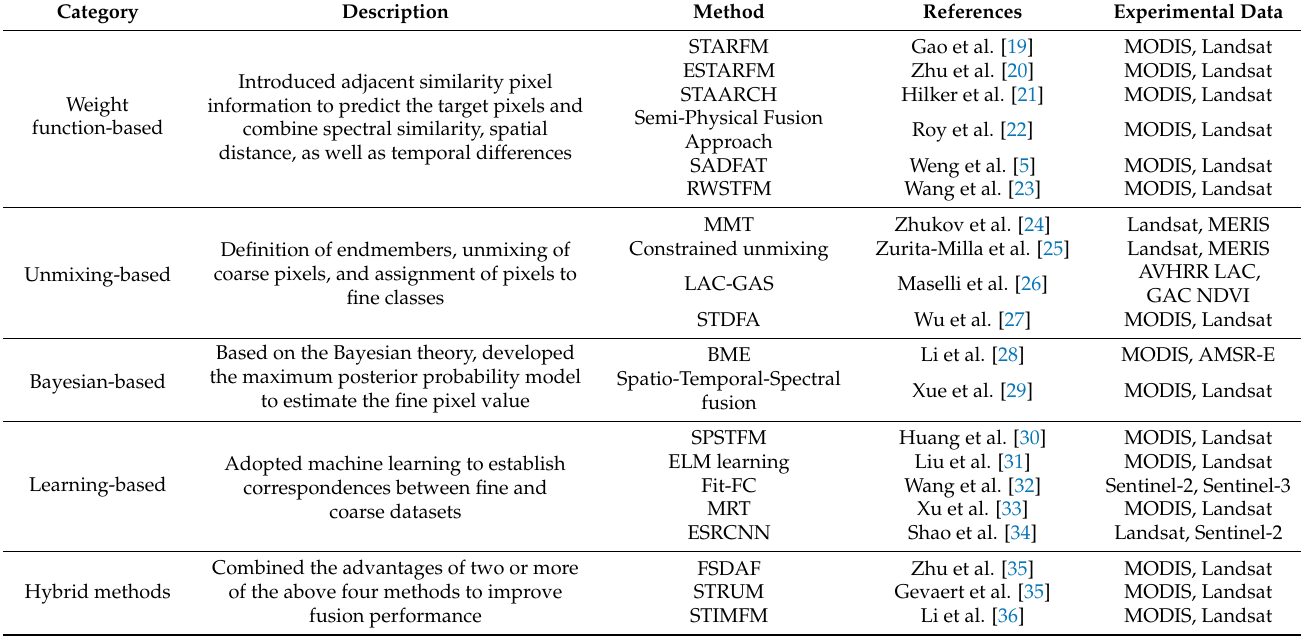
Table 1. Typical spatiotemporal fusion methods and related experimental